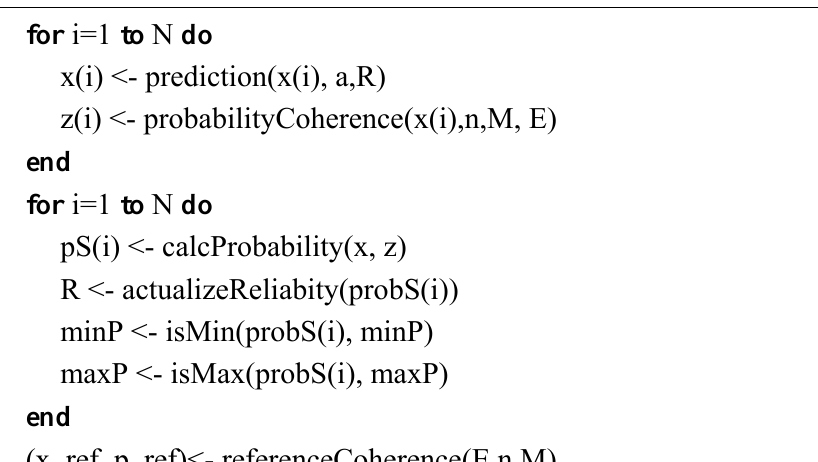
Algorithm 1 : Modified particle